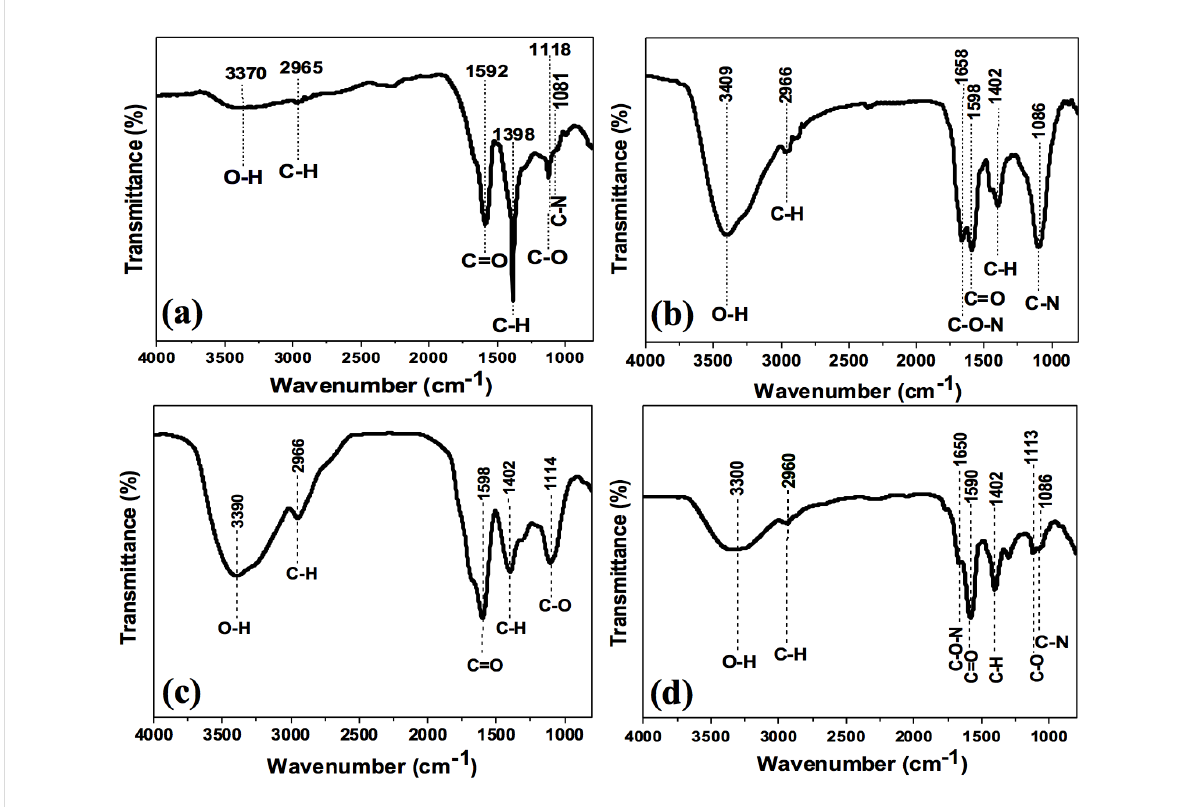
Figure 6: FTIR spectra of (a) cinnamon C-dots, (b) red chilli C-dots, (c) turmeric C-dots and (d) black pepper C-dots.